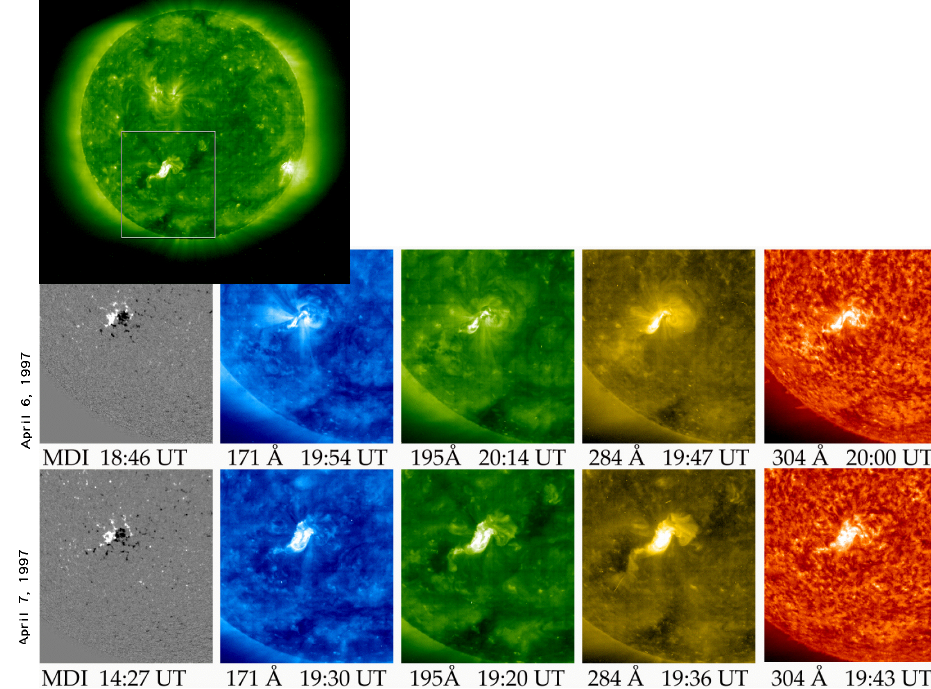
Plate I: A composite showing: full image of the Sun on 195 ˚A Fe XII line (After halo-CME, Event 5). The bright new arcade formation, enclosed by the white box is at AR 8027. White box region in top image is seen from left to right in two rows of images. The first column of images shows some evolution at photospheric level (magnetogram; Scherrer et al., 1995), and in the following columns stronger evolution (typical arcade formation after the lift-off as well as dimming regions in the lower row) for the ions Fe IX-X, Fe XII, Fe XIV light wave-lengths 171, 195, 284. Dimming and arcade formation is less noticeable in the He II 304 ˚A light